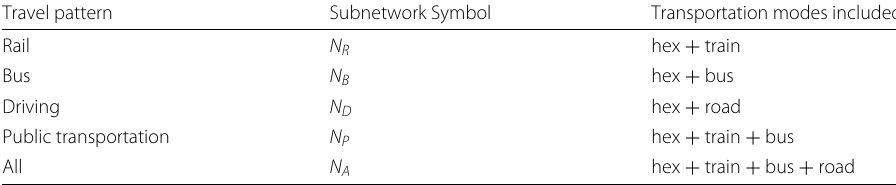
Table 2 The multimodal transportation networks included in each travel pattern we analyse Travel pattern Subnetwork Symbol Transportation modes included Rail N R hex + train Bus N B hex + bus Driving N D hex + road Public transportation N P hex + train + bus All N A hex + train + bus +